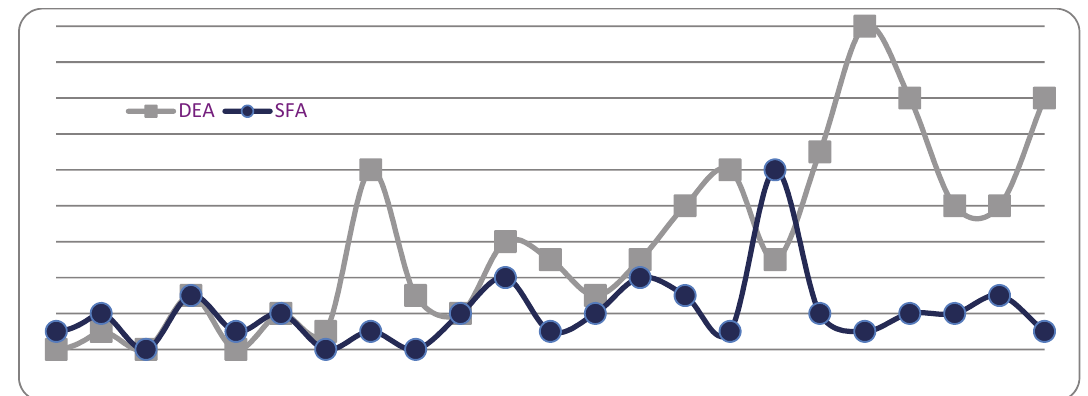
Fig. 7. Number of Life Insurance Efficiency Studies Using Different Methods of Determining Efficiency